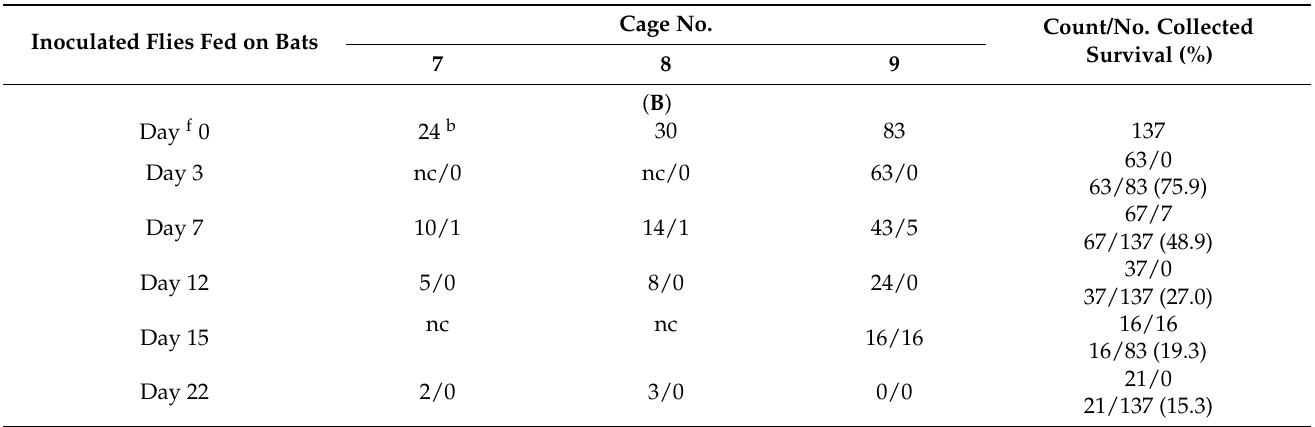
Inoculated Flies Fed on Bats